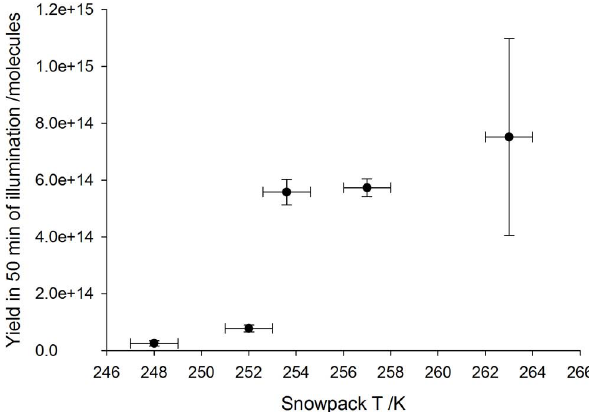
Fig. 5. Dependence of the chlorine (Cl 2 ) yield as a function of snowpack T. Vertical error bars represent the range from two tri- als. Horizontal error bars represent the estimated uncertainty in the snowpack T. The yields were calculated by integrating the Cl 2 concentration-time signal to 50min and scaling by the flow